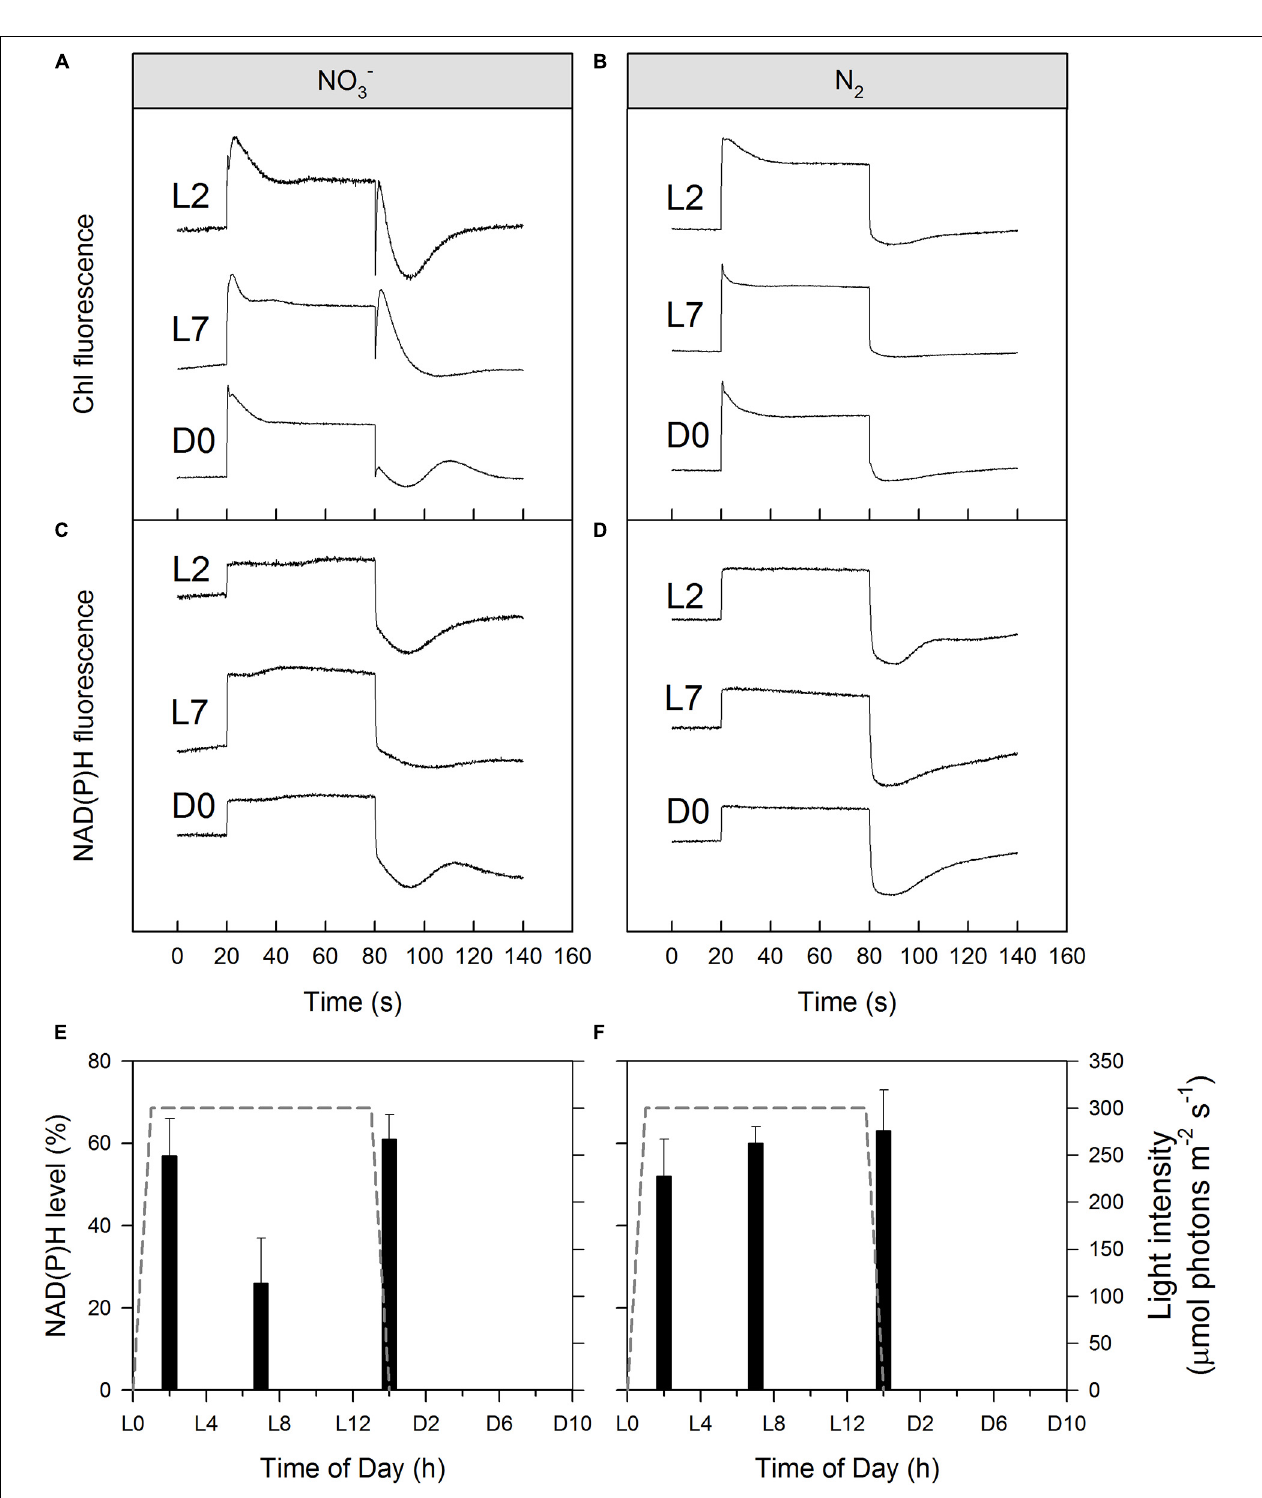
FIGURE 7 | Simultaneously recorded Chl a (A,B) and NAD(P)H fluorescence (C,D) induction curves (with recovery) of Cyanothece cultures during/after the light phase as well as corresponding calculated NAD(P)H levels as a percentage of the entire NAD(P)H:NADP + pool in darkness (E,F) . Cultures were nitrate-rich (A,C,E) or under obligate diazotrophic conditions (B,D,F) . Panels (A–D) show typical induction curves, while data on panels (E,F) represent averages from 3 to 4 replicates, with error bars representing standard deviations. For more details, see Materials and